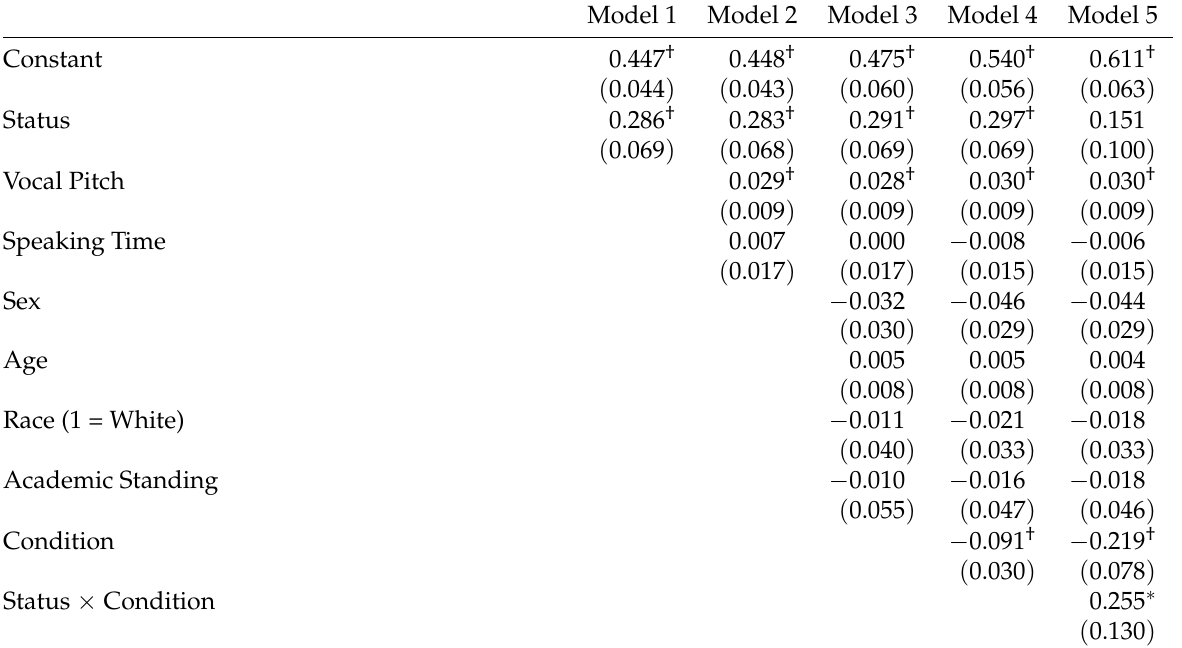
Table 5: GEE predicting vocal accommodation from manipulated status position ( N =